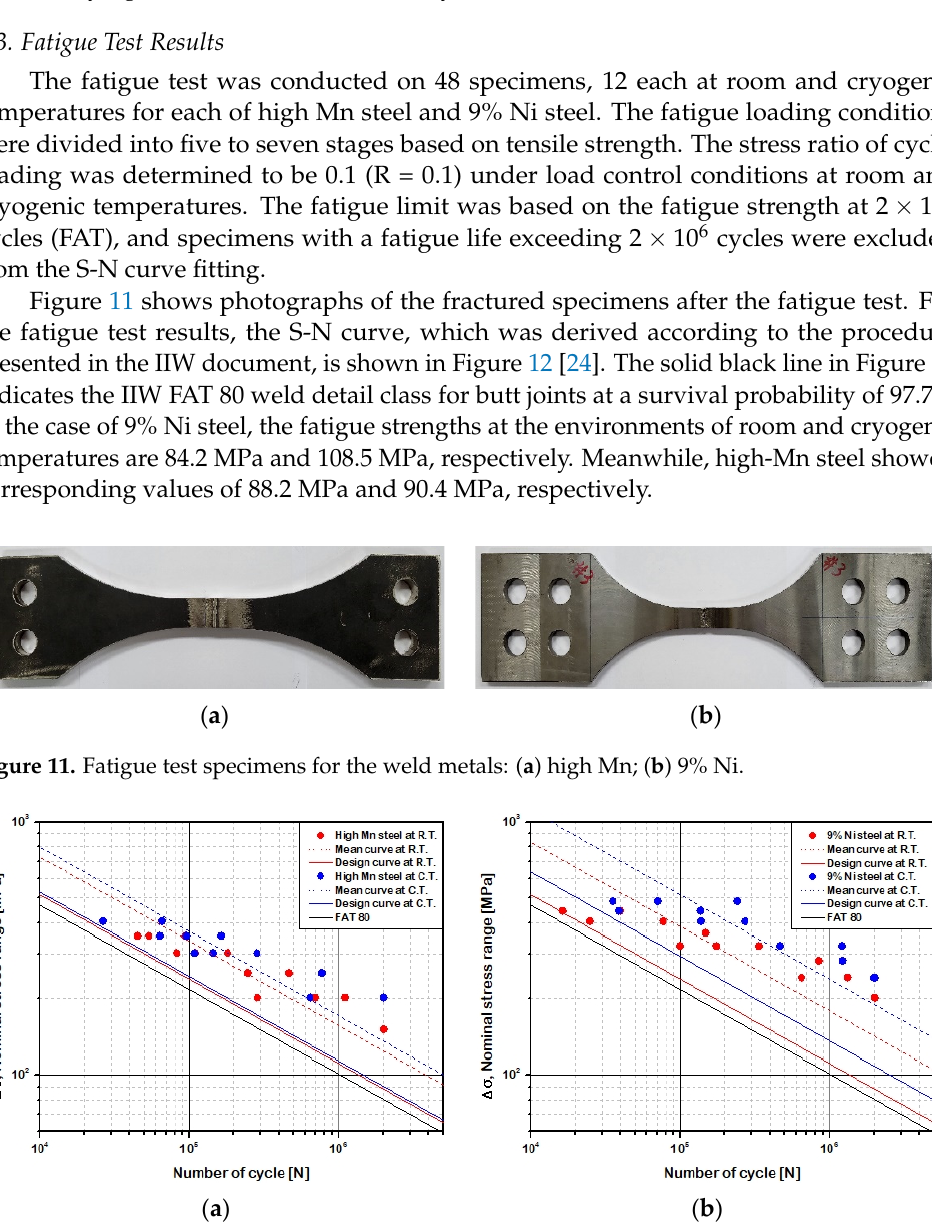
Table 6. The standard deviation for fatigue data of weld metals. High Mn